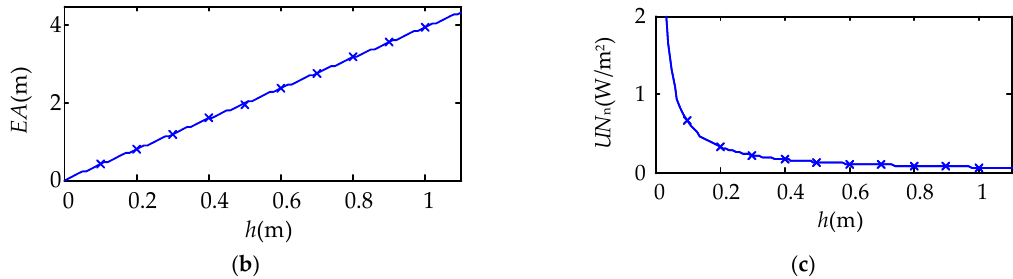
Figure 7. Optimization results of simulated annealing algorithm. ( a ) Optimization results of tube spacing w ; ( b ) optimization results of effective radiation range effective area (EA); ( c ) optimization results of normalized uniformity U N n .